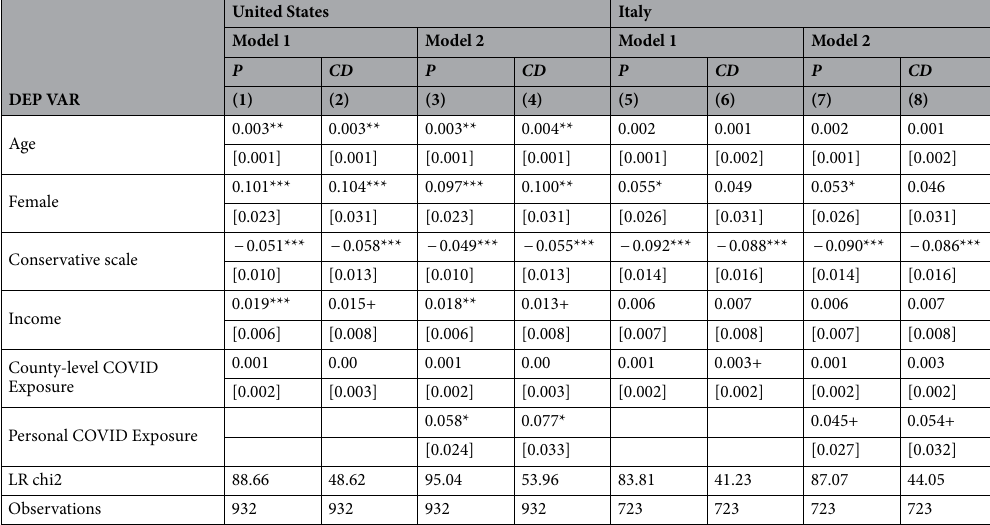
Table 1. Econometric analysis of probability of being a donor ( P ) and of conditional donation ( CD ). Estimates of average marginal effects (AME) from two-part hurdle models are reported. The dependent variable is the share of bonus donated to a charity, without identifying which charity had been chosen. CD is the amount donated conditional on being a donor. The first column in each model reports the marginal effects from a Probit model to estimate P . The second column in each model reports the marginal effects for CD . In addition to the covariates reported above, all models also include controls for education level, indicator for size of respondent’s location, income, whether the individual reported an income loss because of COVID-19, priming (state/country/world), macro-region dummies (South/North for Italy and South/Midwest/Northeast/West for the U.S.), and an indicator identifying individuals who were either born abroad or whose parents were born abroad. The full regression output is reported in the Supplementary Table 2a. Variables are defined in Supplementary Table 1. Standard errors are in brackets. *** = p < 0.001, ** = p < 0.01, * = p < 0.05, + = p < 0.10.